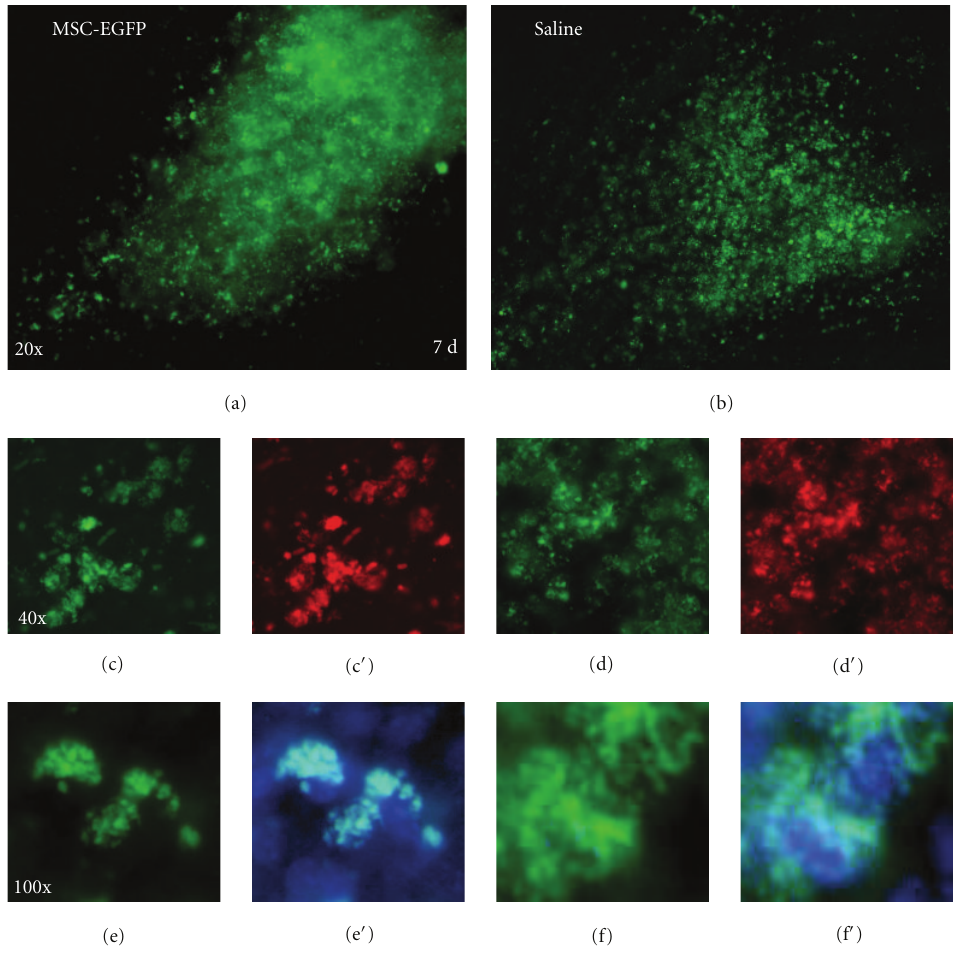
Figure 3: Autofluorescence in the striatum of mice that received mechanical striatal lesions followed 3 weeks later by intranasal saline or MSC-EGFPs. Bright particulate fluorescence is observed at the termination of the lesion injector needle at 7 days after intranasal delivery of MSC-EGFPs (a, c, e) or saline (b, d, f). The number of structures and intensity of fluorescence is the same on the GFP and Texas Red bandpass filters (c (cid:3) and d (cid:3)